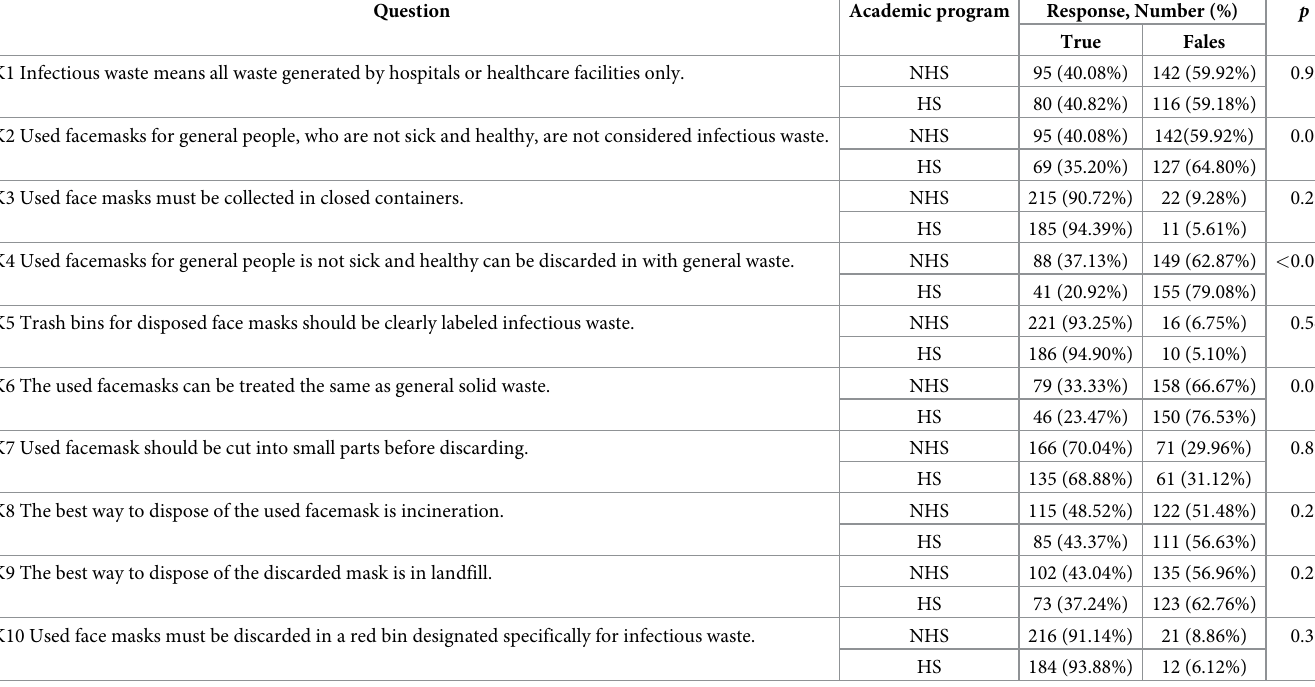
( p < 0.05; Table 2). When their academic grades were compared, the senior students achieved the highest average score (12.78 ± 3.37) for practice. Notwithstanding, no significant differences were observed between the HS and NHS students with regard to facemask disposal practices. More than 90% of the students demonstrated appropriate practices before throwing their facemasks away and washed their hands after discarding the masks to limit viral transmission (Table 4). Only a few students discarded their used facemasks in the correct trash bins. More than half the students collected used facemasks in plastic PET bottles, while 85% collected them in a plastic or zip-lock bags before disposing of them. Table 3. Knowledge of used facemask disposal among the HS and NHS students ( N =